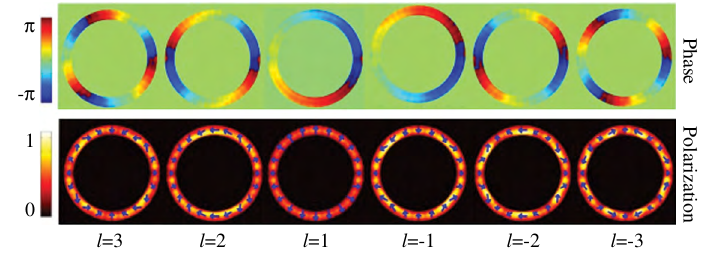
Figure 14 Spatial distributions of phase and polarization of generated OAM-carrying vector beams. Adapted from Ref. [37].